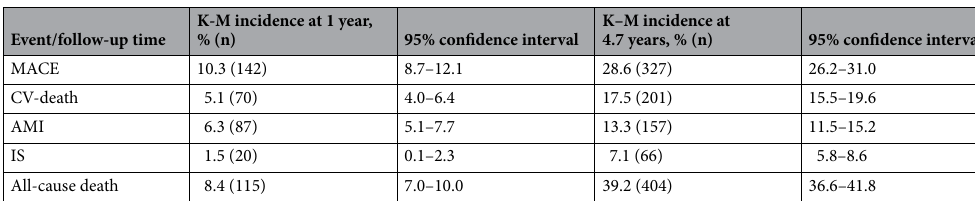
Table 4. Outcomes at 1 and 4.7 years among 1379 ACS patients. MACE major adverse cardiovascular event, CV cardiovascular, AMI acute myocardial infarction, IS ischemic stroke.